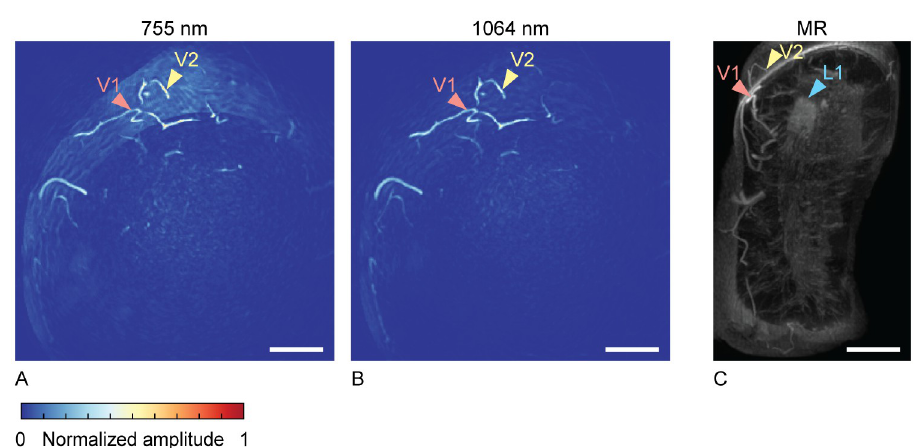
Fig 4. Case 1: Local MIPs of slabs with a thickness of 20 mm, near the main lesion, close to the chest wall, in the coronal view. Photoacoustic images at 755 nm (A) and 1064 nm (B), compared to a post-contrast dynamic T1 MR MIP image (C). All scale bars represent 20 mm.